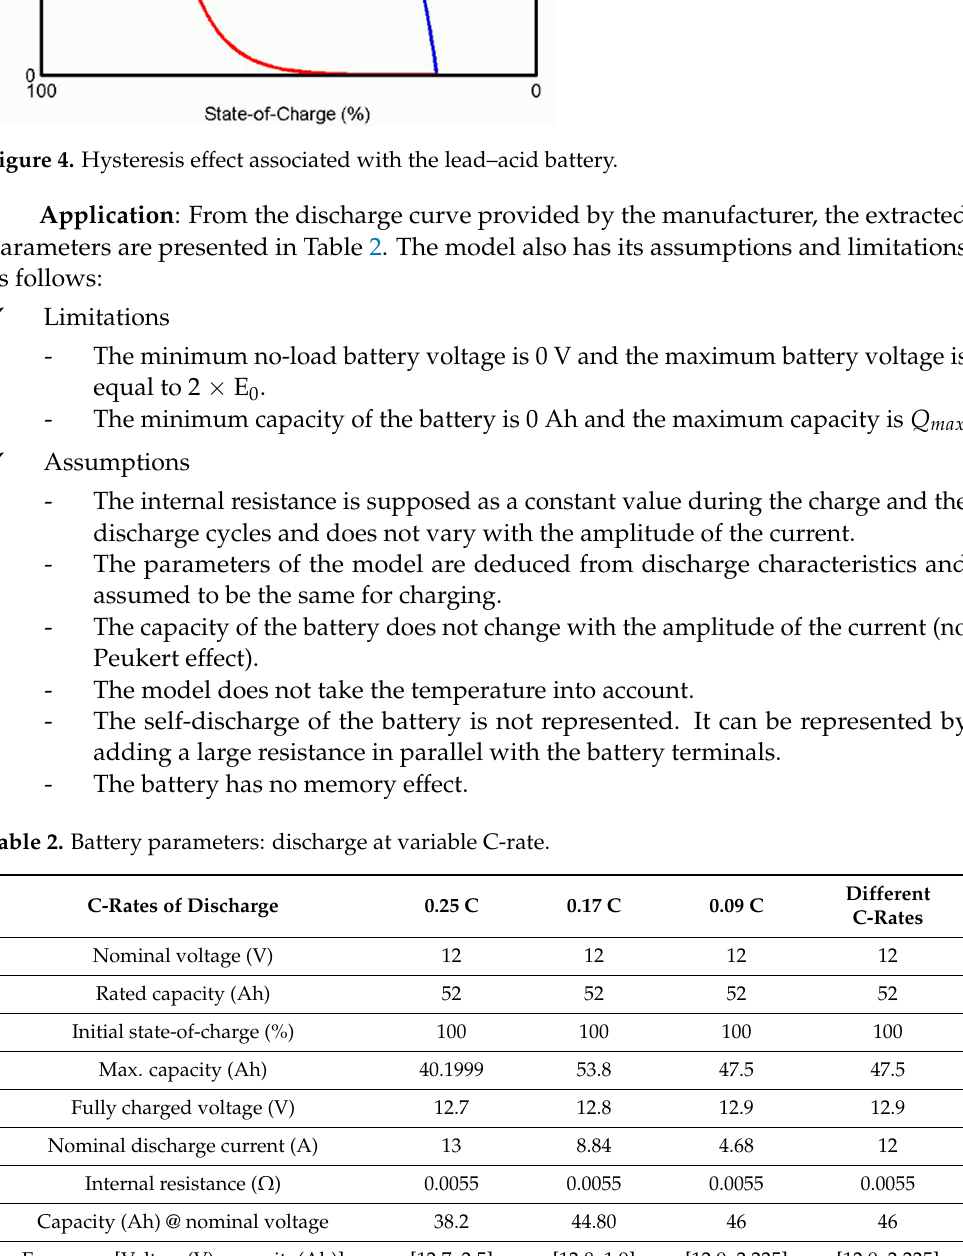
Table 3. Lead–acid battery parameters.